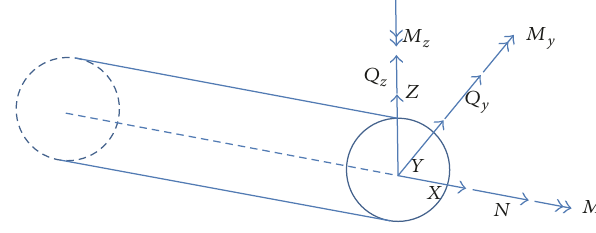
Figure 3: Beam section forces and